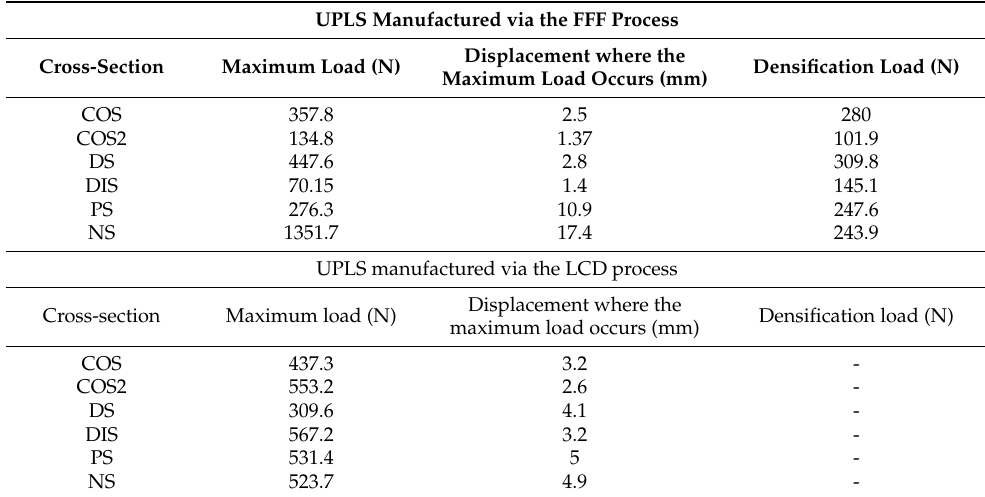
Table 3. Data obtained from compression tests for UPLS